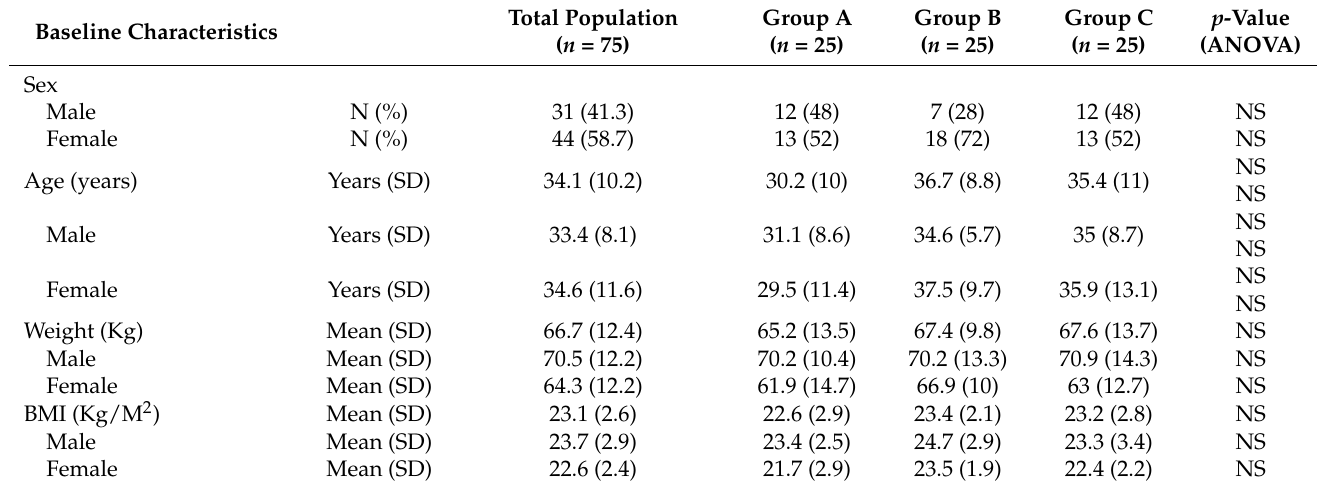
Table 1. Baseline demographic characteristics.